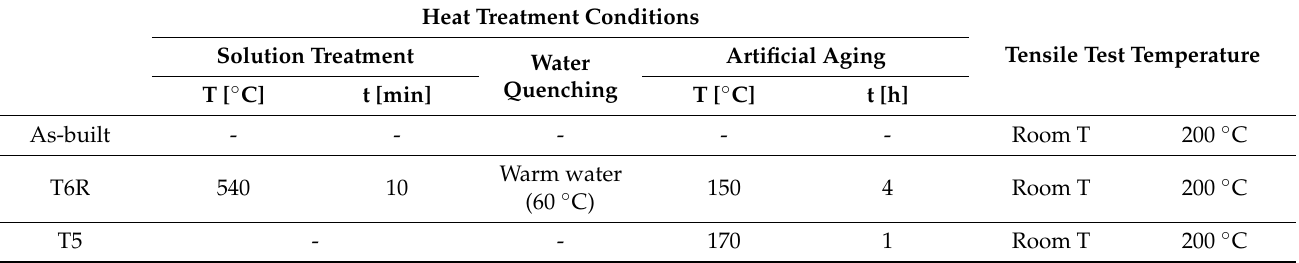
Table 3. Heat treatments (optimized in [25]) and tensile test conditions.